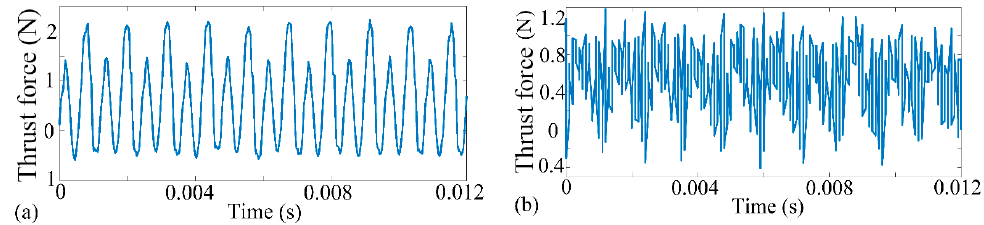
Figure 4. Selected measured cross force during micro-milling process. ( a )—Test 2; ( b )—Test 8.